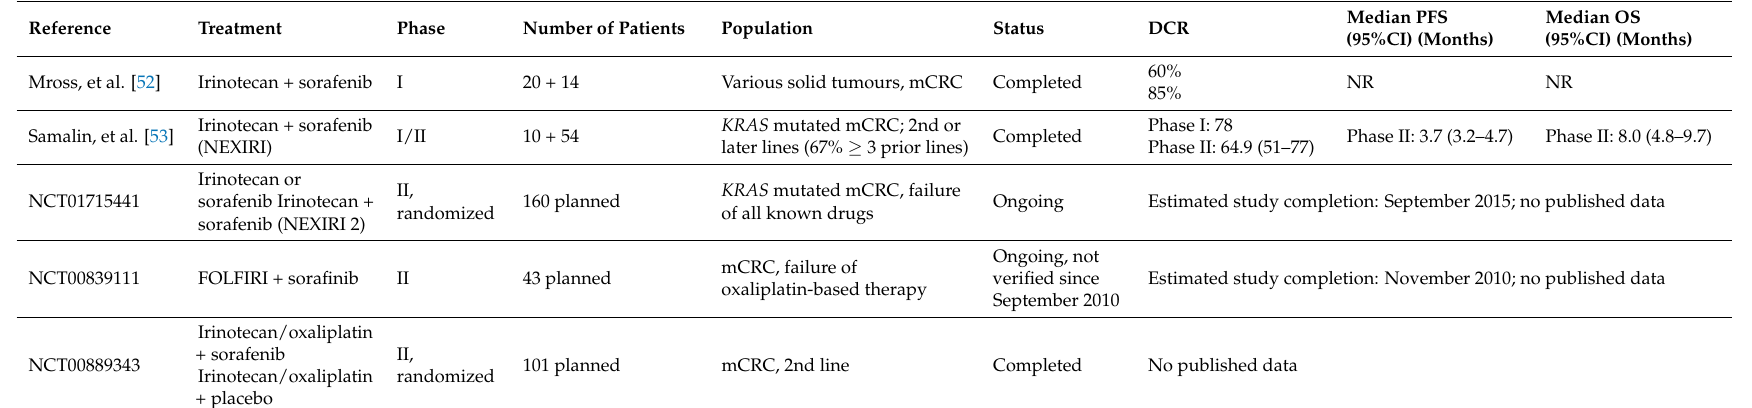
Table 3. Studies on inhibitors of ABCG2 in